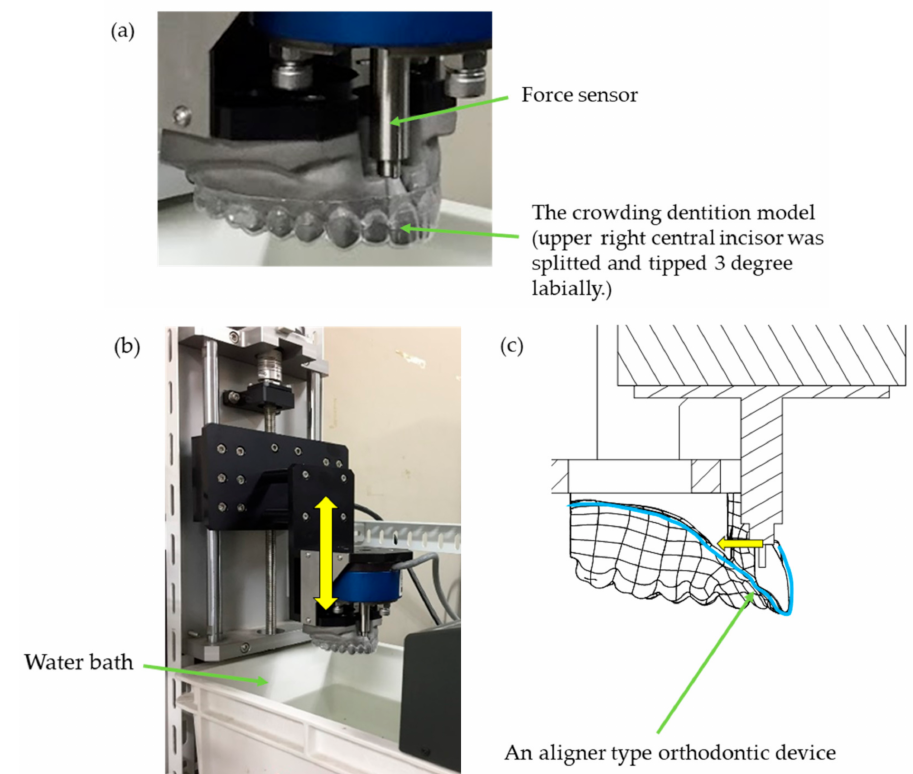
Figure 2. Custom-made device for measuring orthodontic force. ( a ) The upper right central incisor was tilted 3 ◦ to labially, a force sensor was installed at the root 1 / 2 position, and an ER or EC aligner was put on the model. ( b ) The model was fixed to a linear actuator and immersed in a constant temperature bath at 37 ◦ C by adjusting the height (yellow arrow in the figure). ( c ) The model and force sensor. The orthodontic force in the direction of the yellow arrow expressed by the aligner-type orthodontic device (light blue line) was measured at a cycle of 10 times / s.